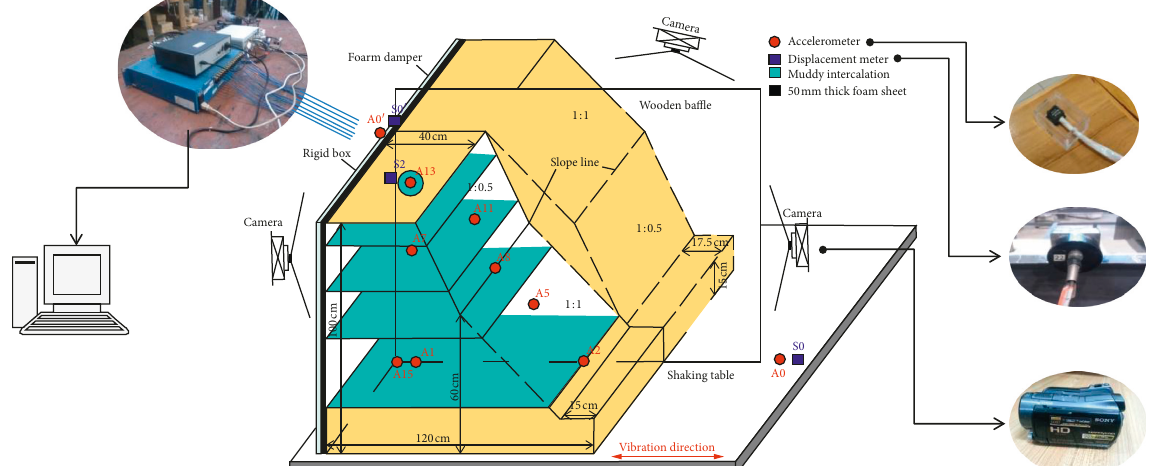
Figure 6: Full dimensions of model slope and layout of measurement points and